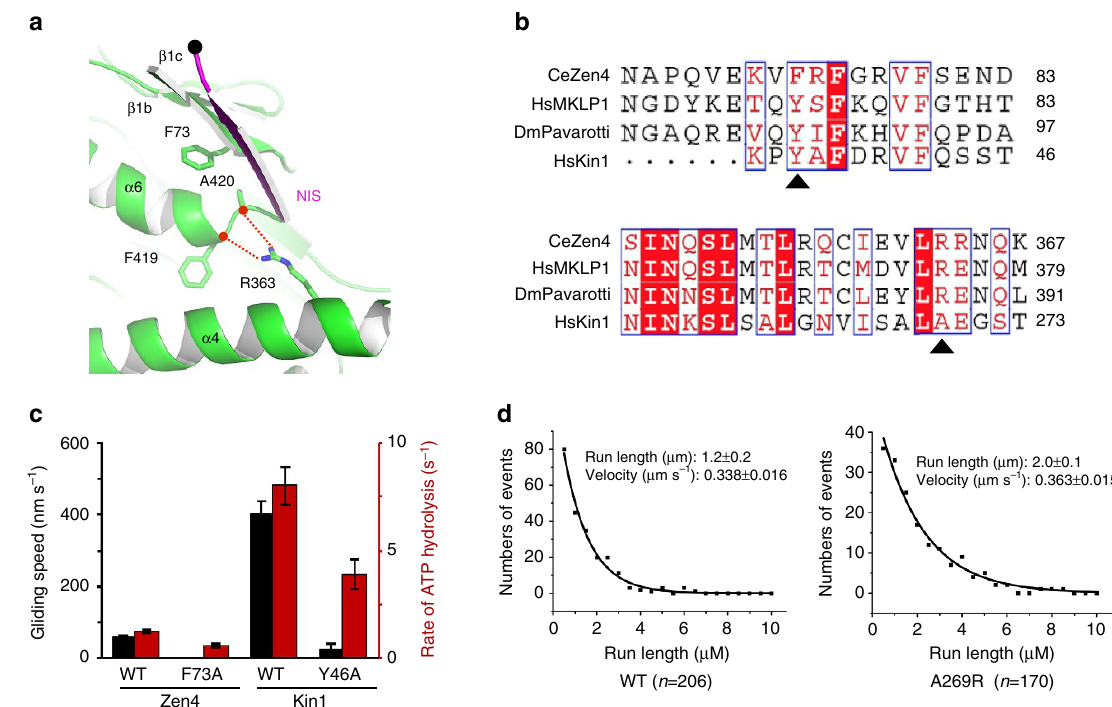
Figure 4 | Unwound a 6 and backward-docked conformation of NIS are essential for the motility of kinesin. ( a ) Interactions that stabilize the melting of a 6 and backward-docked NIS of Zen4. Hydrogen-bond interactions are showed as red dotted lines. ( b ) Sequence alignments around the b 1C (top panel) and a 4 (bottom panel) regions of kinesin-6 family proteins and human kinesin-1. The triangles indicate the positions of the residues mutated in this study. ( c ) ATPase and microtubule gliding activities of the WT and b 1C mutants of Zen4 and rat kinesin-1. Black and red bars indicate the rate of microtubule gliding and ATP hydrolysis, respectively. Error bars indicate standard deviations for at least three independent measurements. ( d ) Run lengths of WT (left panel) and the A269R mutant (right panel) rat kinesin-1 from TIRF assays. Data were fit to a single exponential. n indicates the total number of molecules scored in the